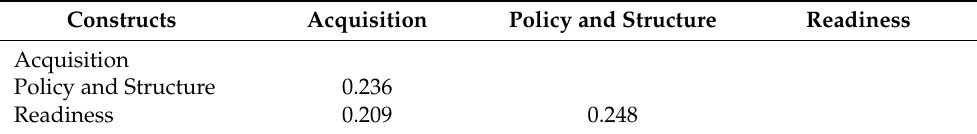
Figure 3. PLS Initial Model. Table 6. The result of the Heterotrait-Monotrait ratio